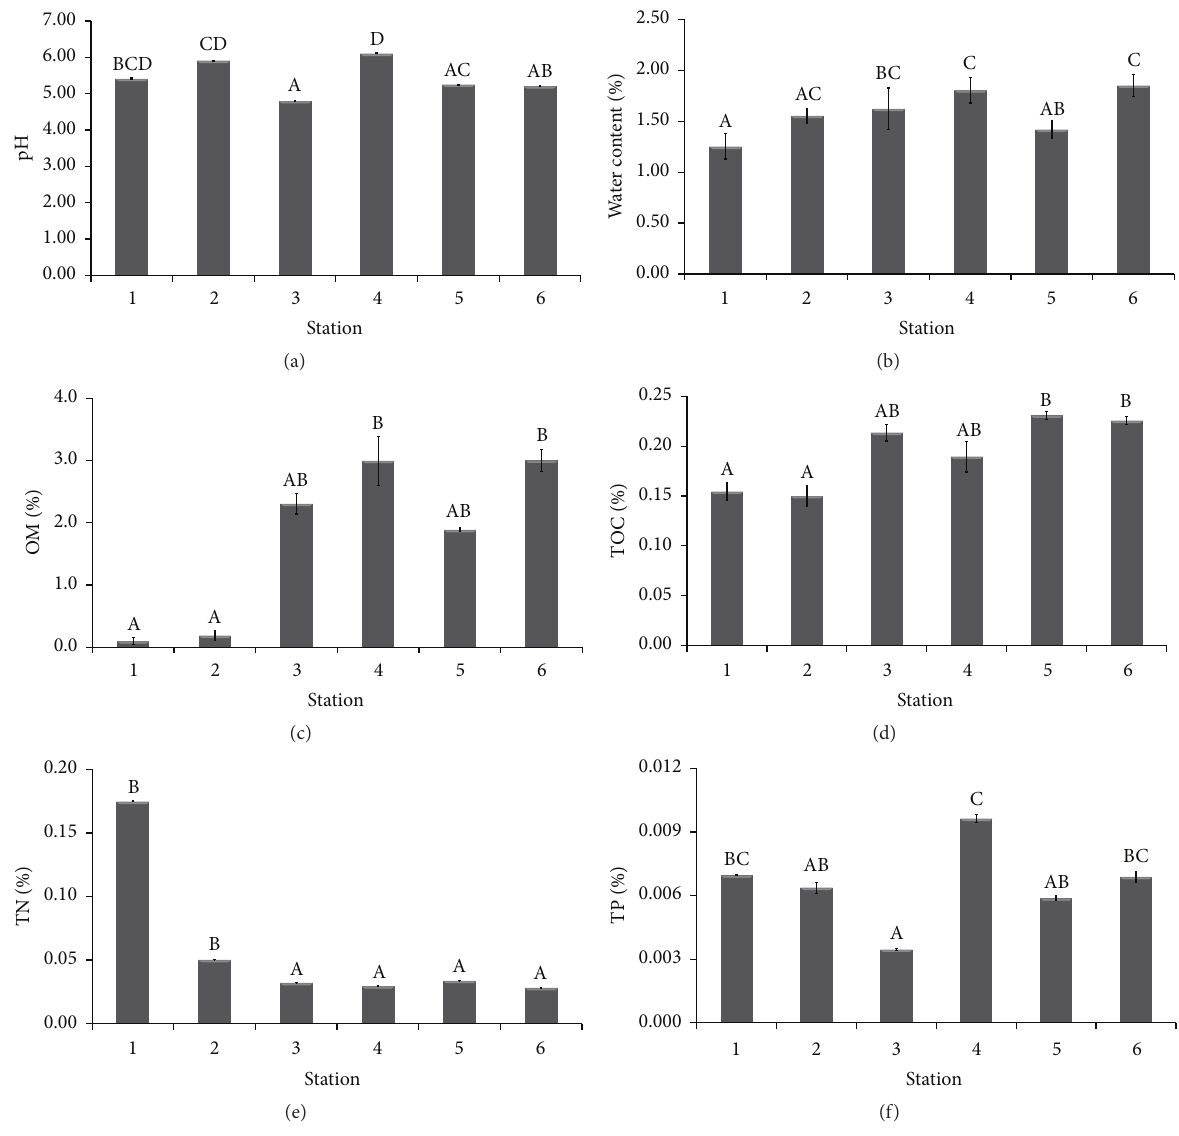
Figure 5: Sediment quality of (a) pH, (b) water content, (c) organic matter (OM), (d) total organic carbon (TOC), (e) total nitrogen (TN), and (f) total phosphorus (TP) collected at the six sampling stations located at the upper reaches of two main tributaries of Batang Baleh (different letters indicate significant difference at 𝑝 value ≤